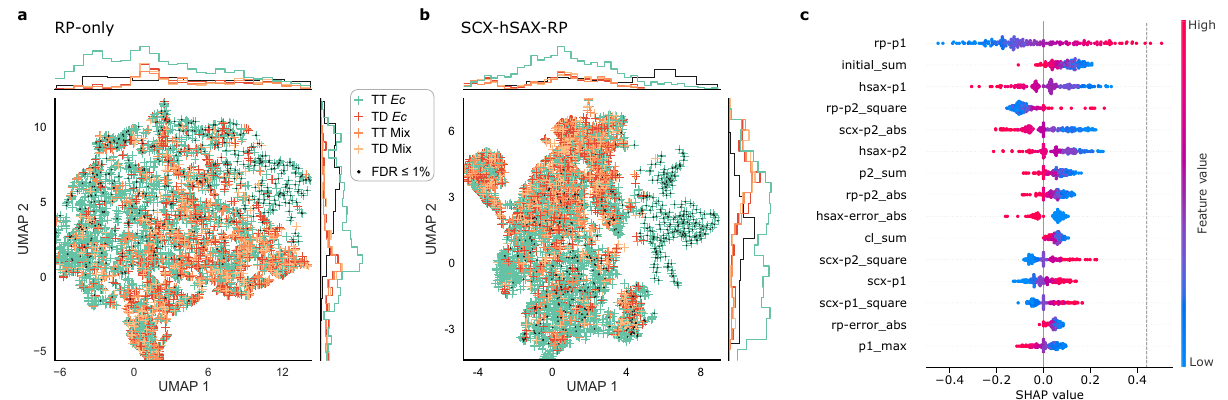
Fig. 3 Visualization of RT features. a xiRT-based features from reversed-phase chromatography (RP) dimension only (13 features) after dimensionality reduction with Uniform Manifold Approximation and Projection (UMAP). b xiRT-based feature from SCX-hSAX-RP (strong-cation exchange – hydrophilic strong-anion exchange – reversed-phase chromatography) dimensions (43 features) after dimensionality reduction with UMAP. Input data for a and b were CSMs of heteromeric links in the proteome-wide crosslinking dataset ( Ec = E. coli ; green = TT; red = TD, Mix = match between E. coli and human peptides; orange = TT; peach = TD), fi ltered to 50% CSM-FDR. Identi fi cations passing 1% CSM-FDR are highlighted. Decoy-decoy identi fi cations are not shown. c SHAP analysis of RT feature importance for CSM-rescoring (using a linear SVM) including SCX, hSAX and RP features (Supplementary Table 4). Each dot represents a previously identi fi ed CSM from 200 randomly chosen TTs that were excluded from training (i.e., CSM-FDR > 1%). The background data set consists of 100 TT and TD CSMs each. Dashed line indicates the base value for a prediction based on the background data alone (0.44). Source data are provided as a Source Data fi le.